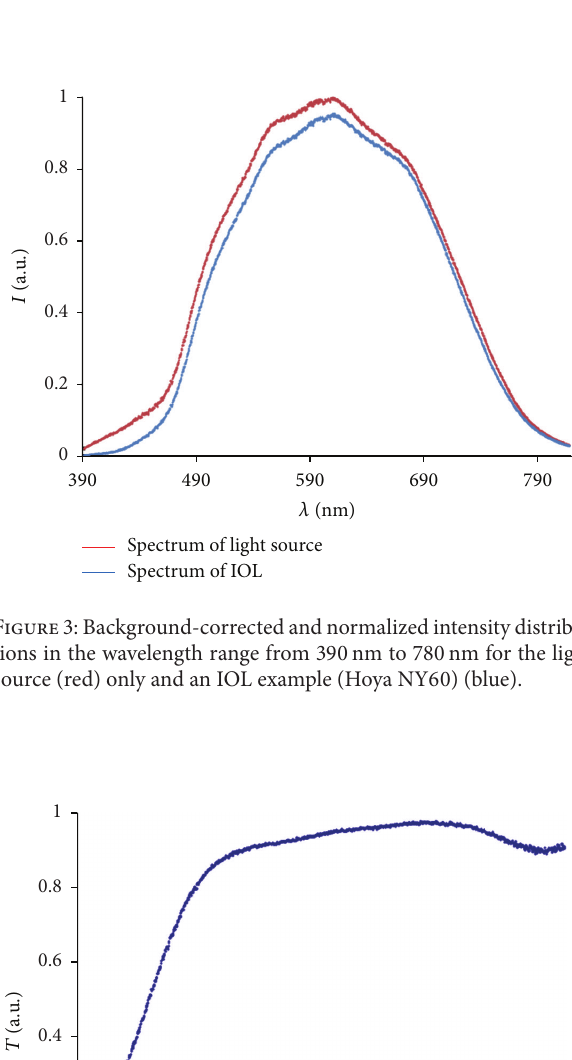
Figure 2: Schematic illustration of the experimental setup for nor- malization of the intensity spectrum with IOL (for the wavelength 633 nm). The pinhole ensured that no stray light was incident on the power meter (Powermeter 1918-R, Newport Corporation, Irvine, CA/USA).